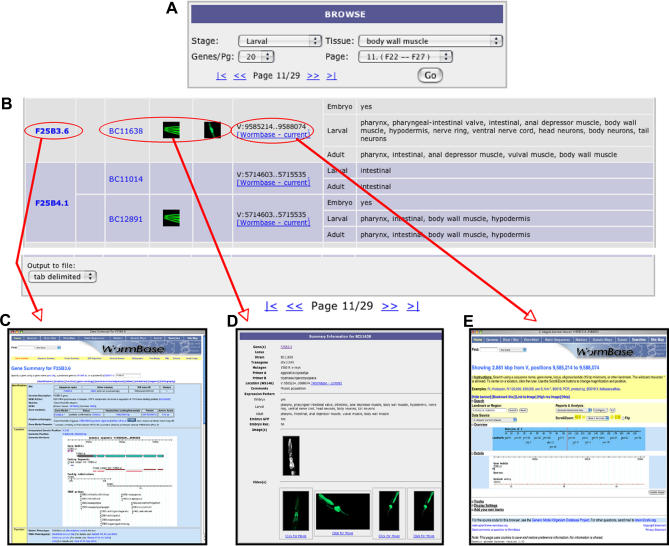
The Browse PageThe Browse page initially lists all genes (B) with the relevant information as text or links, but is searchable (A) by developmental stage or a specific tissue. The links lead to (C) the Wormbase Gene Summary, (D) a comprehensive summary page specific to that strain, and (E) the Wormbase location map.